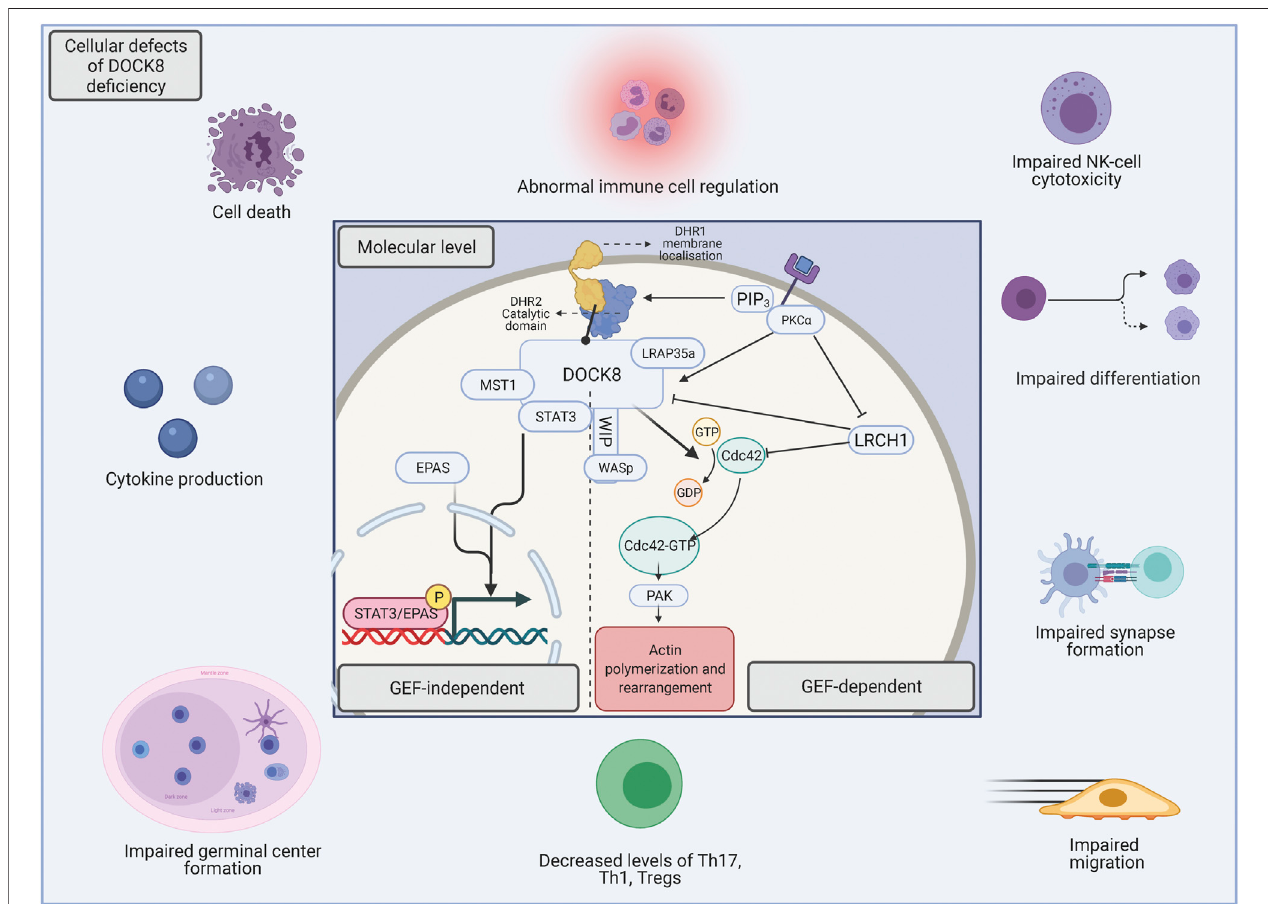
FIGURE2| TheunderlyingmolecularfoundationforDOCK8de fi ciency.TheperturbationofDOCK8expressiondisturbsabroadspectrumofimmunecellfunctions such as differentiation, survival, migration, activation, immunotolerance and -function (McGhee and Chatila, 2010). The basis of the various functions of DOCK8 can be divided into either GEF-dependent actin regulation or functions within GEF-independent pathways. When chemokines bind to extracellular receptors, phosphoinositide 3 kinase (PI3K) is activated and initiates the production of phosphatidylinositol (3,4,5)-triphosphate (PIP3), which recruits DOCK8 via the DHR-1 subunit, which consequently leads to membrane-adjacent GEF activity (Xu et al., 2017; Sakurai et al., 2021). In addition, when chemokines bind extracellular receptors, PKC α is activated, which phosphorylate DOCK8 for dissociation from Leuchine Rich Repeats And Calponin Homology Domain Containing (LRCH1) (2), thus diminishing its inhibitory impact (Xu et al., 2017). The catalytic DHR2 domain of DOCK8 interacts with the nucleotide-free form of the Rho GTPase Cdc42, and mediates activation through GDP-GTP exchange (Harada et al., 2012) and leads to down-stream regulation of several biological activities such as cell morphology, -survival, -signaling and -cytoskeletal dynamics, all mediated through p21-activated kinases (PAK) (Bokoch, 2003). In addition to the aforementioned functions, DOCK8 loss in the GEF- independent pathways leads to nuclear translocation of EPAS1 promoting IL-31 production (Yamamura et al., 2017). Furthermore, DOCK8 associates with the transcription factor STAT3 and facilitates activation-induced STAT3 translocation to the nucleus. Here, the guanine nucleotide exchange function of DOCK8 is also necessary for optimal STAT3 phosphorylation and Th17 differentiation (Su et al., 2019).